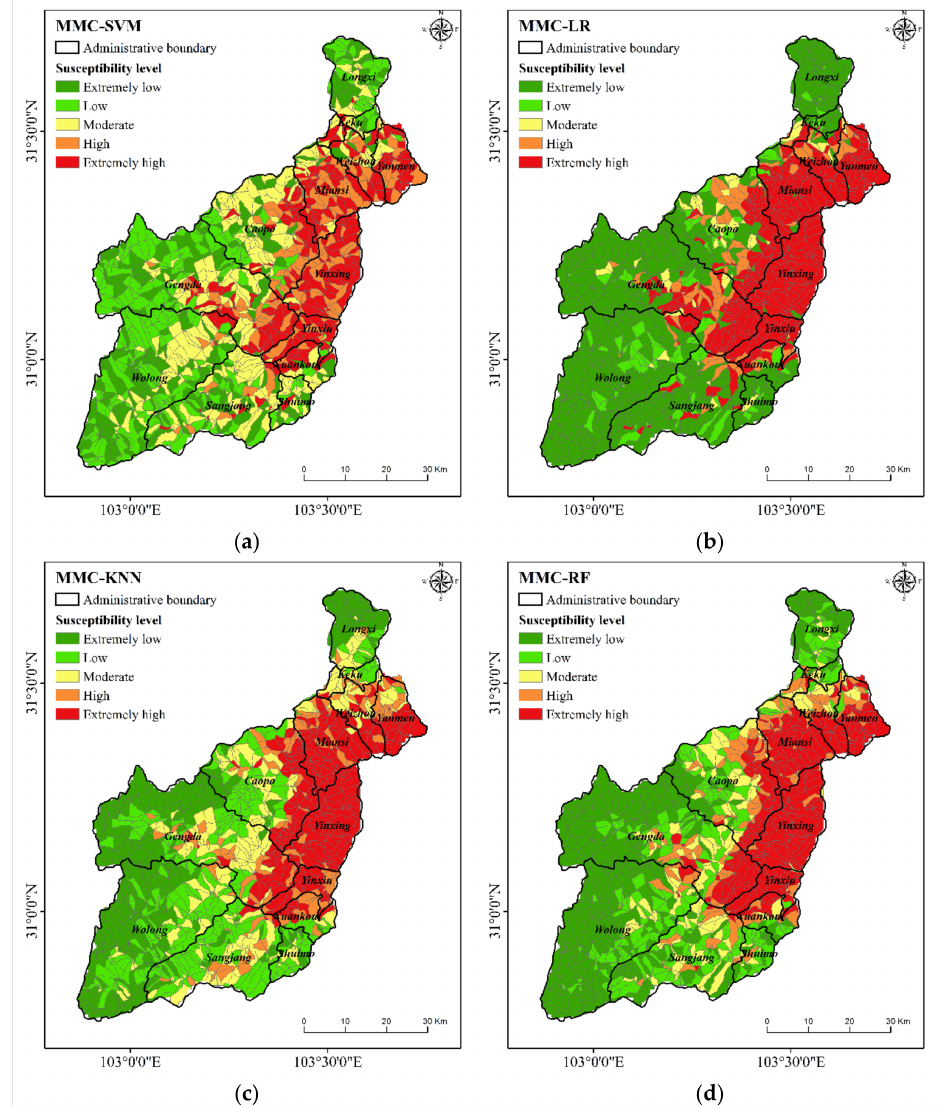
Figure 12. Landslide susceptibility maps produced by different methods considering data